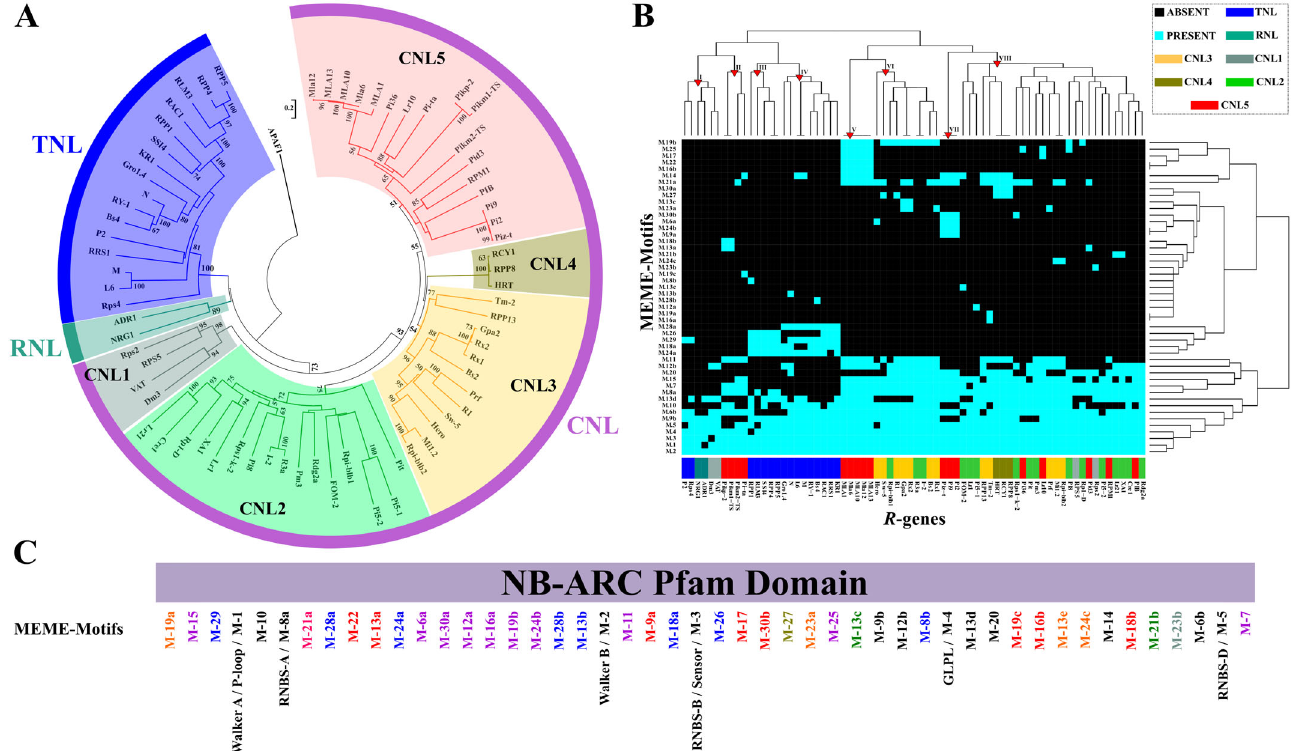
Figure 3. Diversification patterns of the NB domain in the plant R ‐ gene family. ( A ) Phylogenetic tree of 70 well ‐ characterized R ‐ genes. The seven phylogenetic clades are indicated with different colors. ( B ) Organization of motifs along the NB Pfam sequence. Motif IDs (M1 ‐ M30) and physical order are indicated. The colors are related to panel A. ( C ) Hierarchical cluster analysis of NB motifs. The color of each cell of the heatmap is based on the presence/absence of a specific NB motif in that R ‐ gene. Eight R ‐ gene clusters are indicated using red triangles. The colors of R ‐ genes are related to panel A.